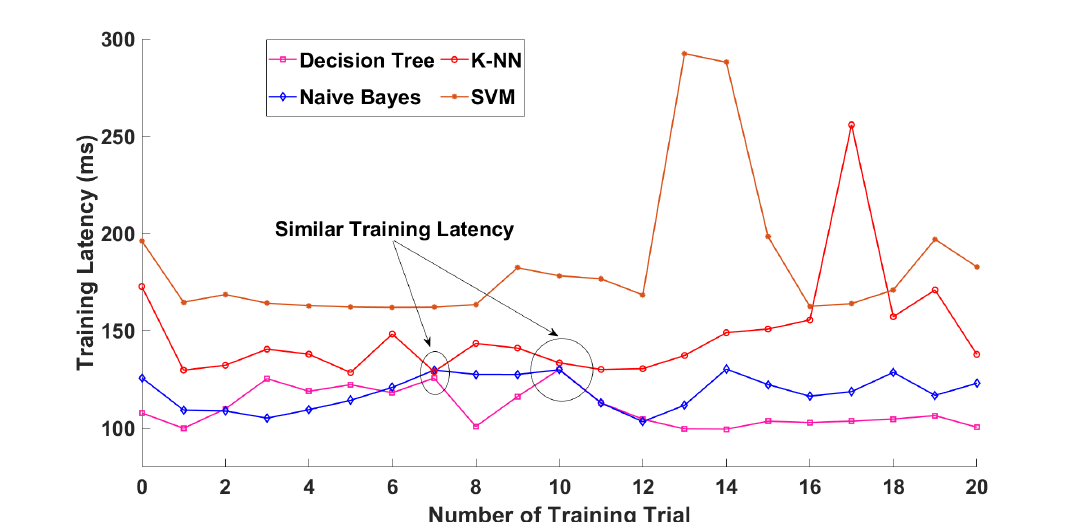
Figure 15. Comparison of NTCA training